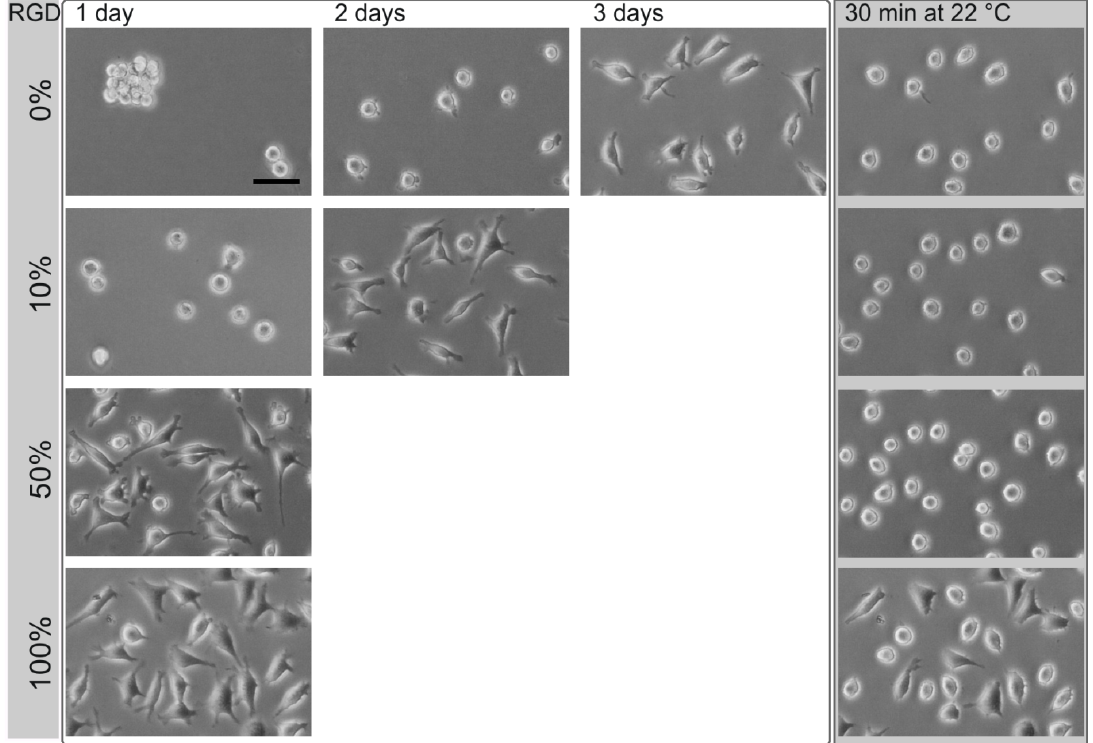
Figure 3. Phase contrast images of L929 mouse fibroblasts on different thermoresponsive substrates, produced by coadsorption by varying the ratios of poly(MEO and RGD peptide (percentage, left column). The total concentration of the coating solution was 50 µM. The time needed for complete cell spreading after seeding, strongly depended on the amount of the peptide. After cell spreading, the samples were exposed to room temperature (~22 °C) for 30 min (right column). The scale bar is 50 μ